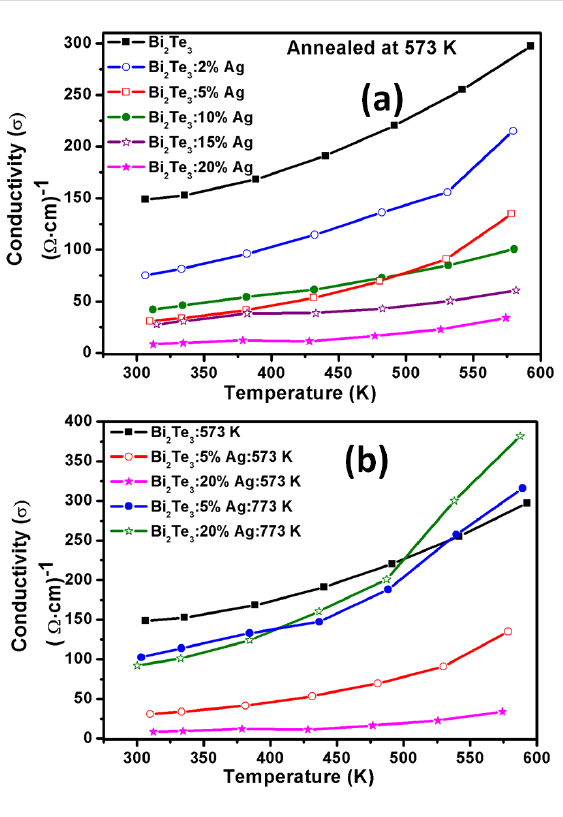
and the HRTEM image of the Bi 2 Te 3 sample 5% Ag annealed at 773 K. One can observe nanoparticles with 3D hexagonal structures along with smaller hexagonal structures which vary from 40 to 80 nm for the large structures and from 2 to 20 nm for the small structures. Figure 4b of Bi 2 Te 3 with 20 wt % Ag annealed at 773 K shows that particles with mostly hexagonal shaped structures with a wide distribution of sizes from 10 to 60 nm are formed.